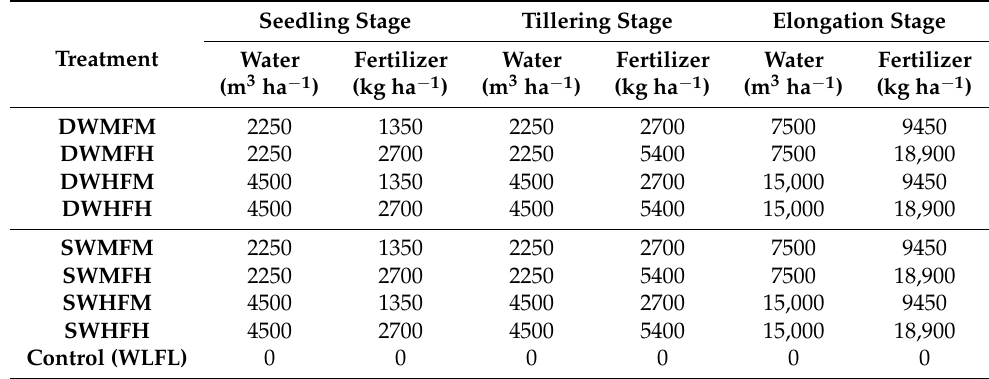
Table 1. Experimental design: Drip (D) or spray (S) irrigation, and 0% (Water Low, WL), 50% (WM), or 100% (WH) of the optimal irrigation level, and 0% (Fertilizer Low, FL), 50% (FM), or 100% (FH) of the optimal fertilization level, at three different growth stages of sugarcane.